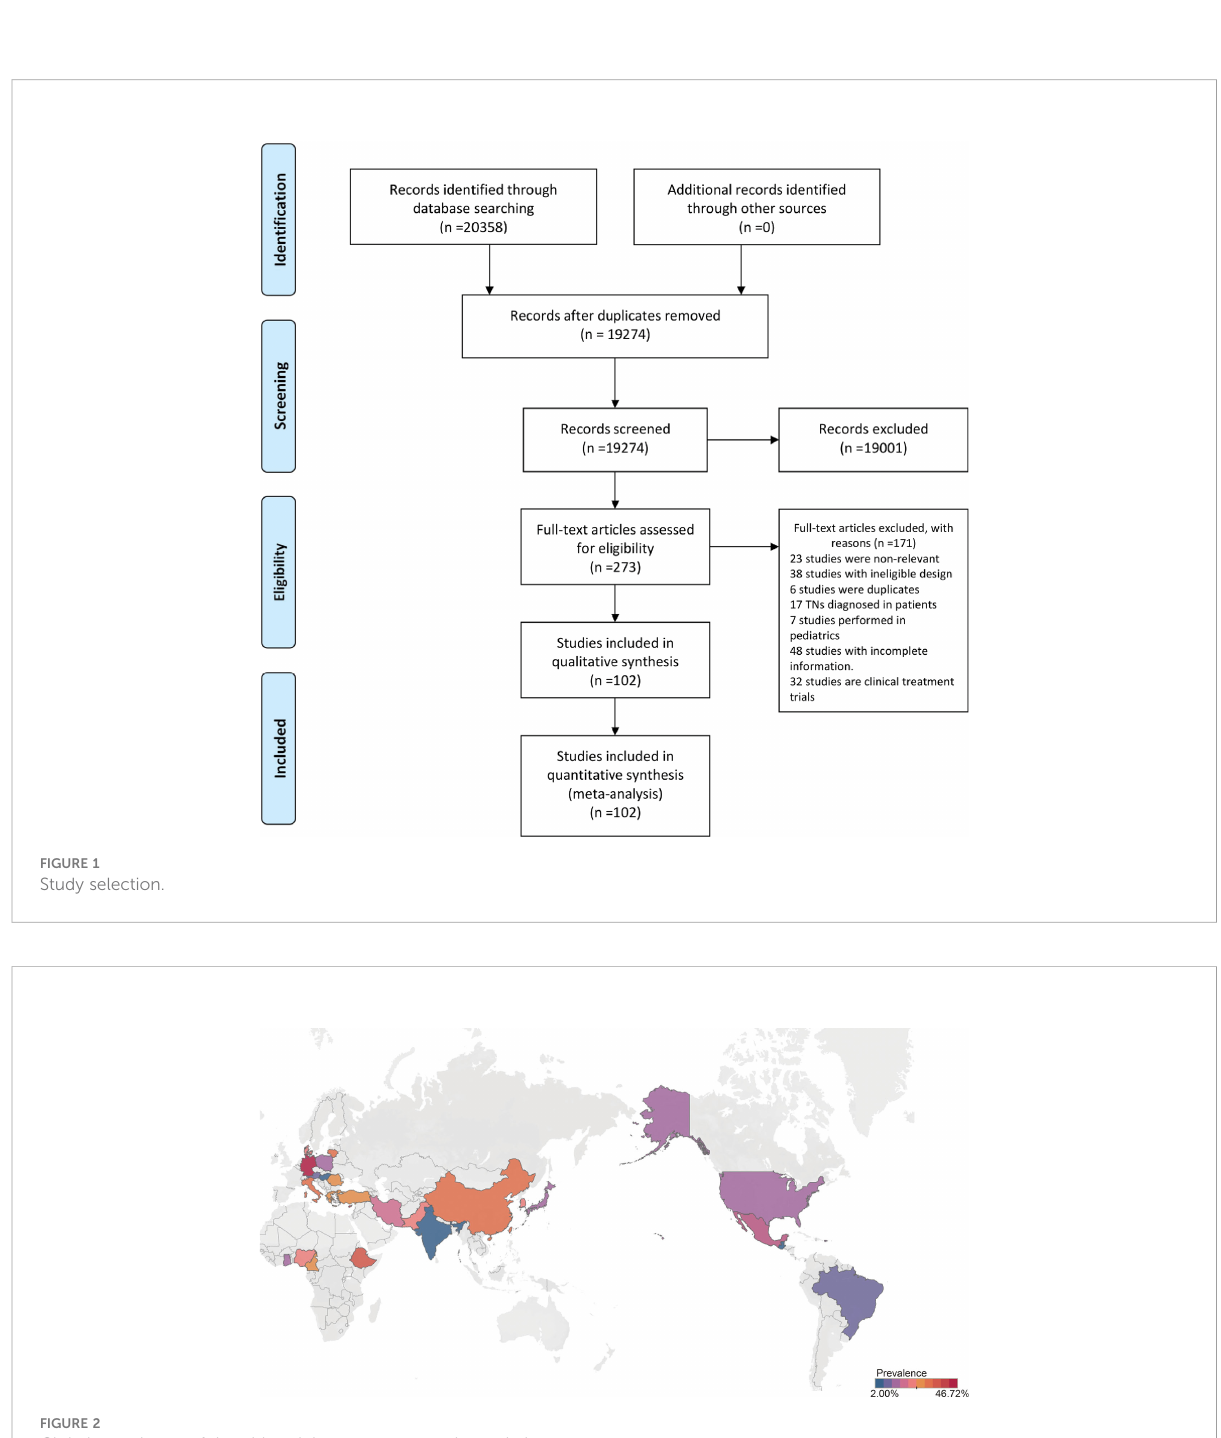
FIGURE 2 Global prevalence of thyroid nodules among general population.